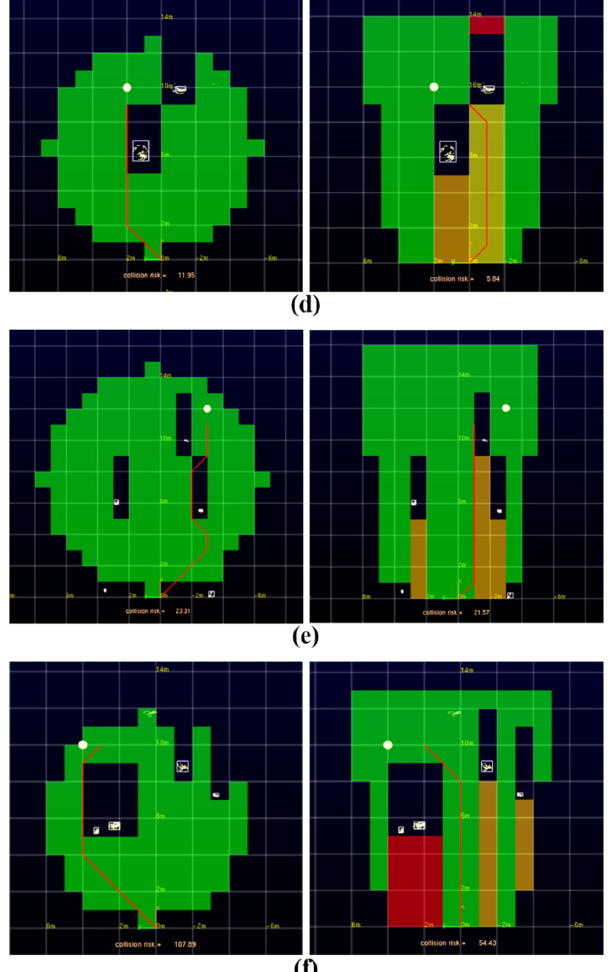
Figure 9. Generated path comparison of FSD without speed information in circular grid map and FSD with speed information in trapezoid grid map in cases ( a )–( f ). Table 6. Collision risk (CR) in cases ( a )–( f ).